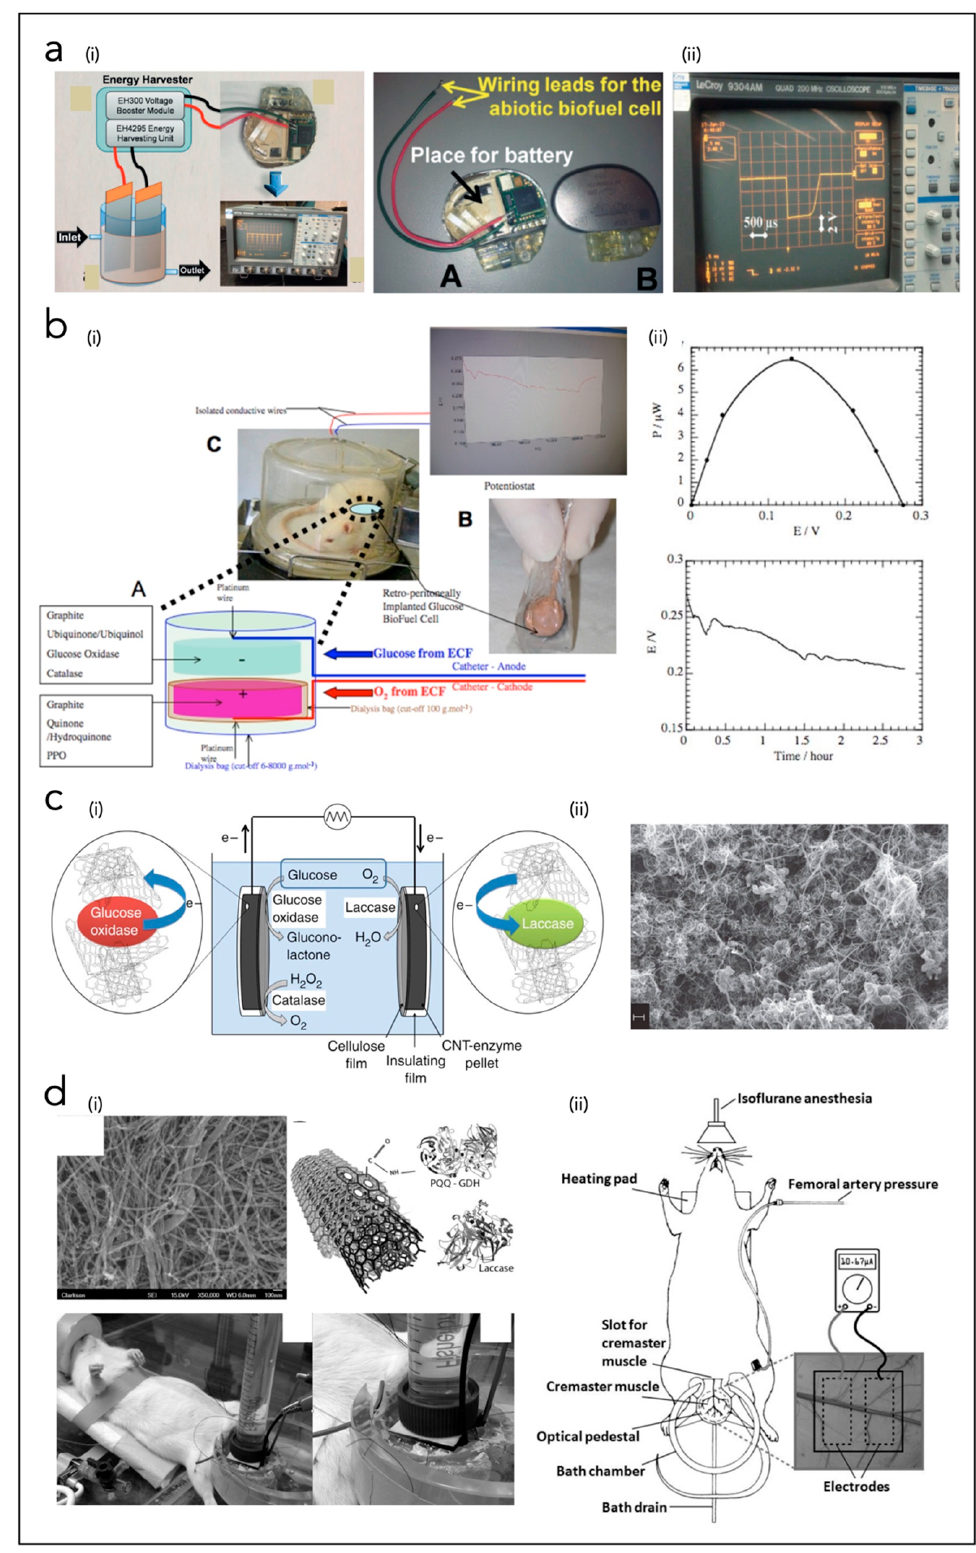
Figure 6. BFCs for heart energy harvesting. ( a ) Flow abiotic BFC coupled with an energy harvesting circuit (i) to power a pacemaker and make it apply electrical pulses (ii). Adapted with permission from reference [46], 2014 Copyright Wiley. ( b ) Glucose BFC based on graphite modified with ubiquinone, glucose oxidase, and catalase (anode), and with quinhydrone and polyphenol oxidase (cathode) (i), implanted in rats for energy harvesting (ii). Adapted from reference [185]. Creative Commons Attrib- ution License. ( c ) BFC based on compressed carbon nanotube-enzyme electrodes (i). At the anode (ii), glucose is oxidized to gluconolactone, where the electrons are transferred from the GOX to CNT. Cat- alase decomposes hydrogen peroxide into oxygen and water. At the cathode, electrons are transferred